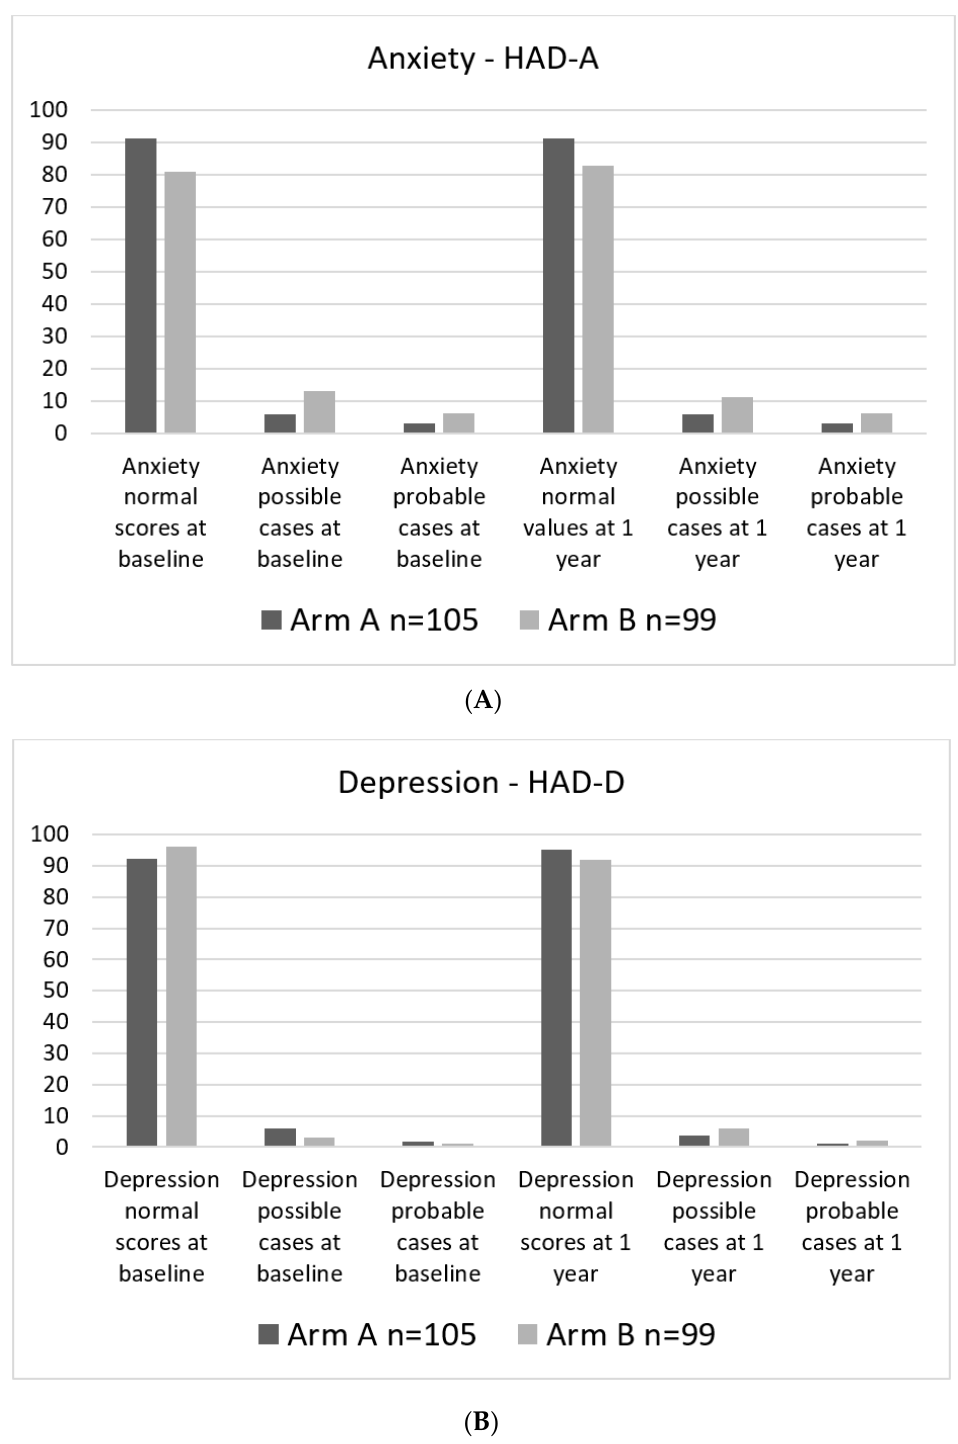
Figure 4. Percent of patients in each category. ( A ). HAD-A categorical at baseline and 1 year. ( B ). HAD-D categorical at baseline and at 1 year.